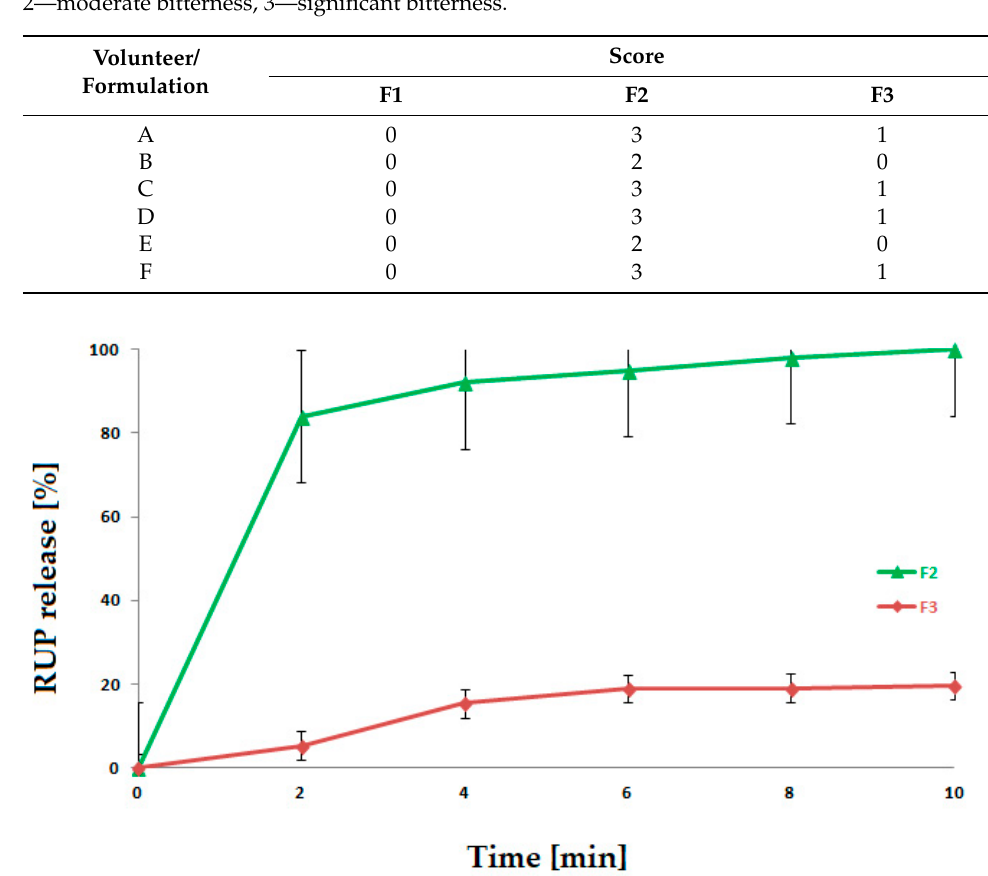
Figure 3. RUP dissolution from nanofibrous mats (F2, F3) evaluated in a type II apparatus.